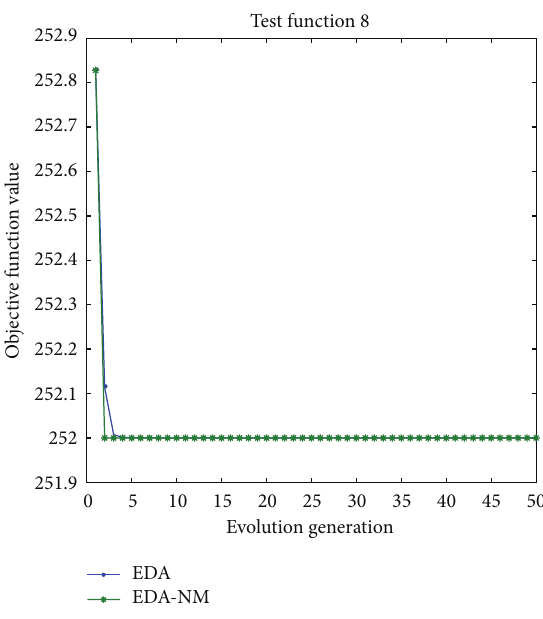
Figure 5: Convergence figure on test problem 8.